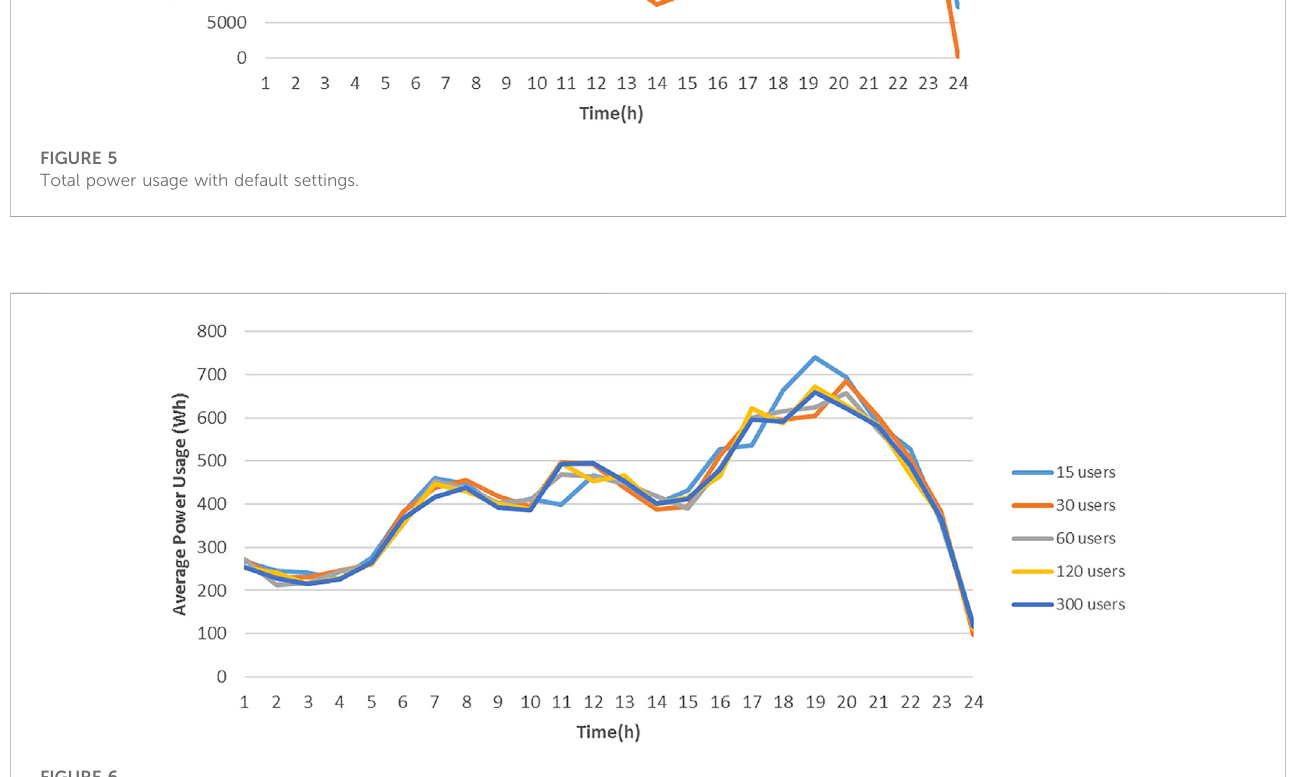
FIGURE 6 User power usage with different user numbers.